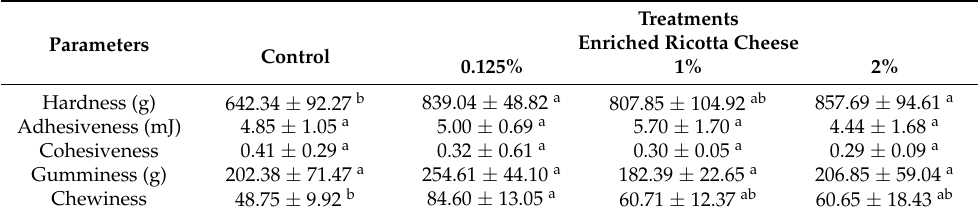
Table 5. Texture profile analysis (TPA) of ricotta cheese enriched with various concentrations of liposomal saffron